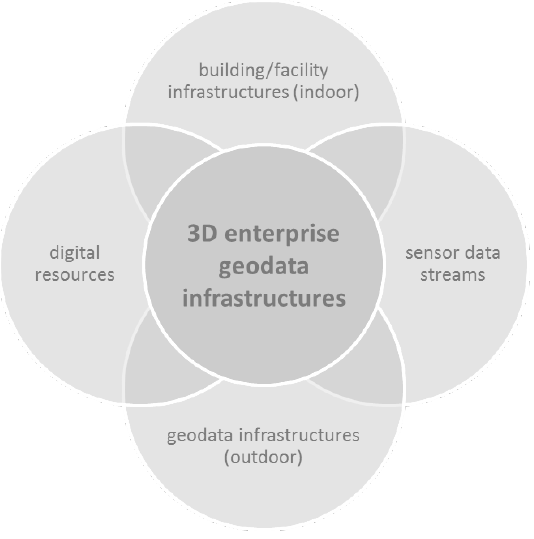
Figure 1. Components of a 3D Enterprise